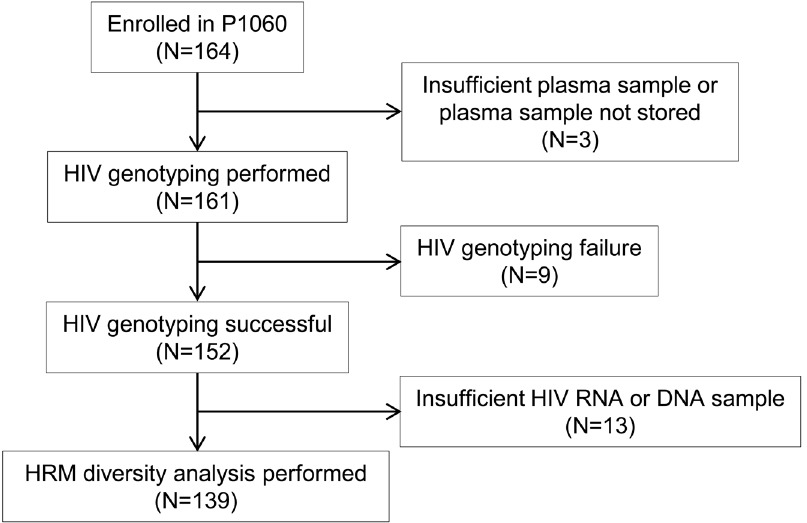
Figure 1. Study cohort. The high resolution melting (HRM) diversity assay was used to analyze samples from 139 (84.8%) of the 164 children enrolled in Cohort I of the P1060 trial. The 139 children had HIV genotyping results at study enrollment (prior to initiation of antiretroviral treatment) and had sufficient HIV RNA or DNA remaining after genotyping for analysis using the HRM diversity assay.